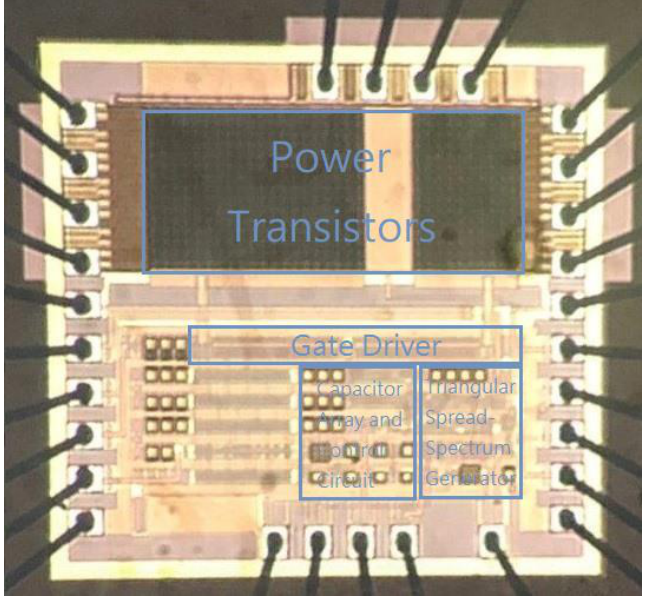
Figure 9. Chip microphotograph. Figure 9. Chip